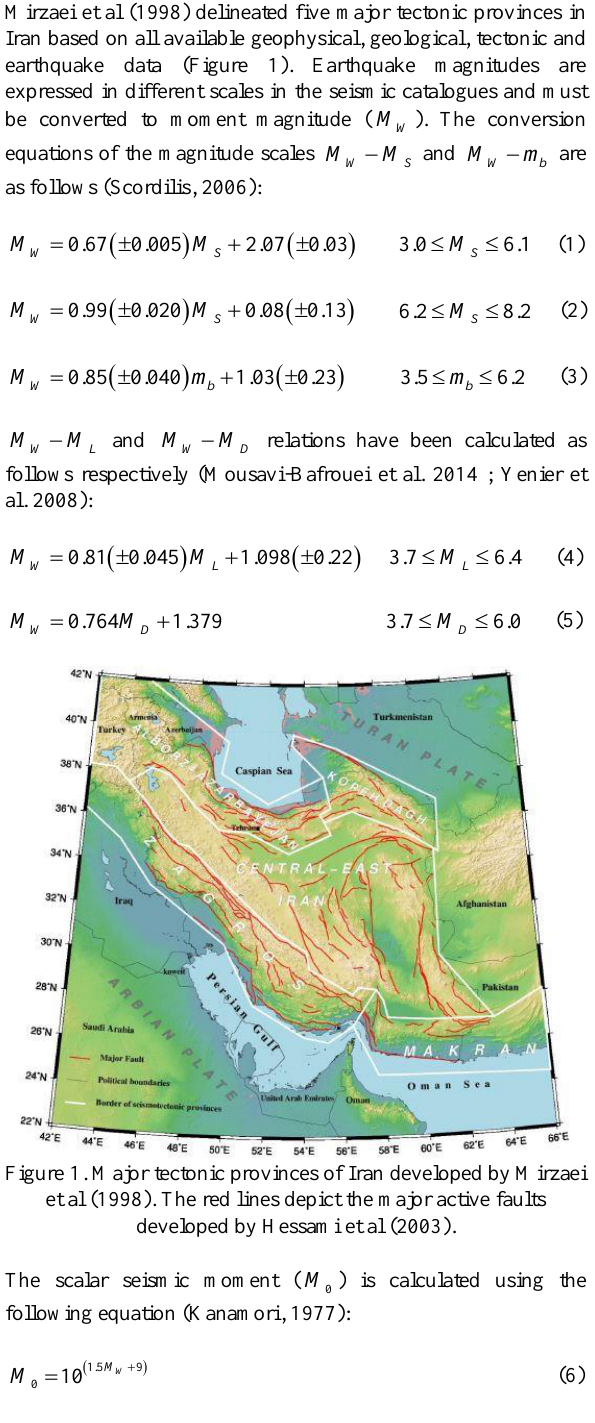
using the Delaunay